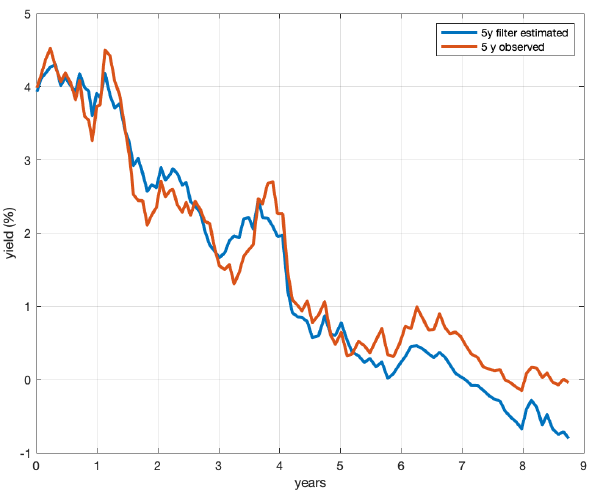
Figure 5. Comparison between the market yield rate (blue line) and the model − implied yield rate (red line) for the 5 − year